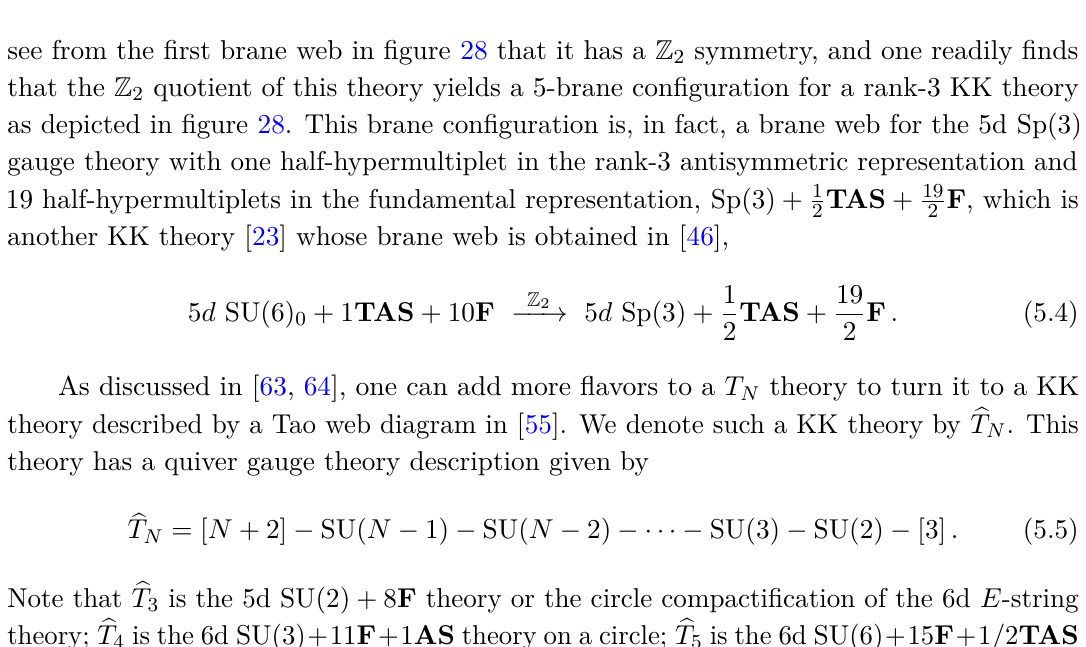
Figure 28 . The Z 2 quotient of 5d SU(6) 0 + 1 TAS + 10 F leads to a 5-brane configuration for 5d Sp(3) + 1 TAS + 19 F 2 2